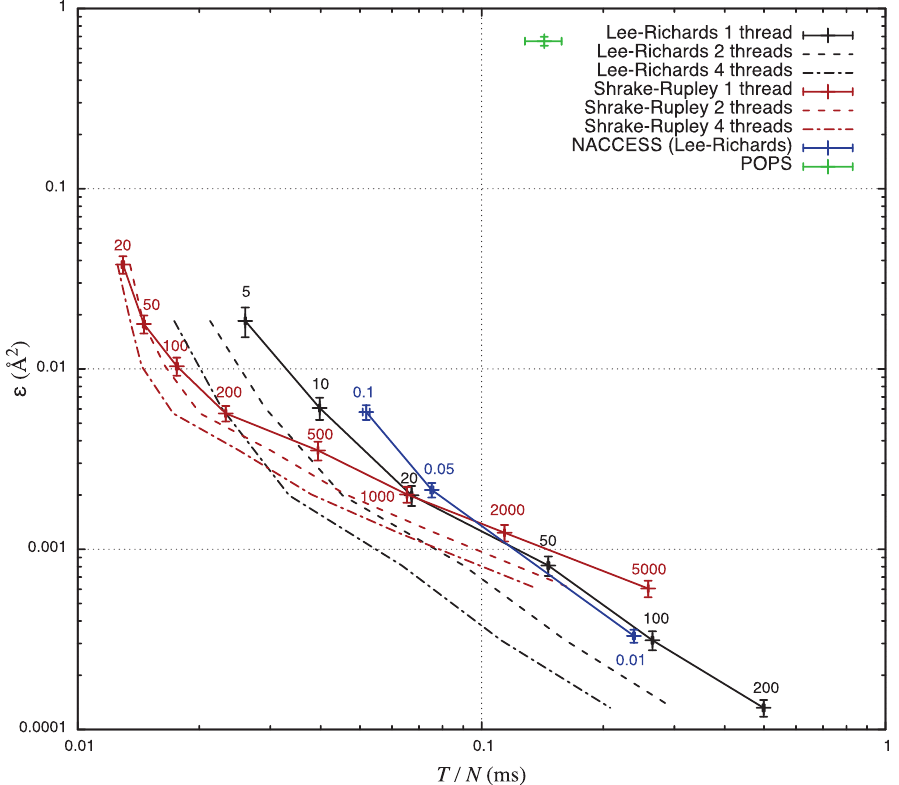
Figure 2. Precision and calculation time. The mean of the error ε in SASA vs T / N , for the two algorithms in FreeSASA plus the programs NACCESS and POPS. Labels indicate the resolution used for each set of calculations, and error bars the standard error along both axes. The solid lines are only there to guide the eye, and the dashed lines indicate the analogous lines when using 2 and 4 threads in FreeSASA. An L&R run with 1000 slices was used as